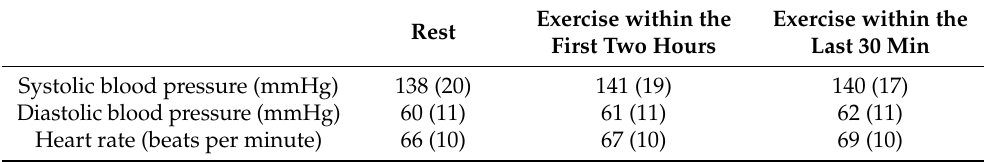
Table 2. Hemodynamic control during the hemodialysis sessions. Exercise within the Exercise within the Rest First Two Hours Last 30 Min Systolic blood pressure (mmHg) 138 (20) 141 (19) 140 (17) Diastolic blood pressure (mmHg) 60 (11) 61 (11) 62 (11) Heart rate (beats per minute) 66 (10) 67 (10) 69 (10) The data are shown as mean and standard deviation (SD) for blood pressure and heart rate determined during full HD session at rest, HD session with exercise within the first two hours, and HD session with exercise within the last 30 min.